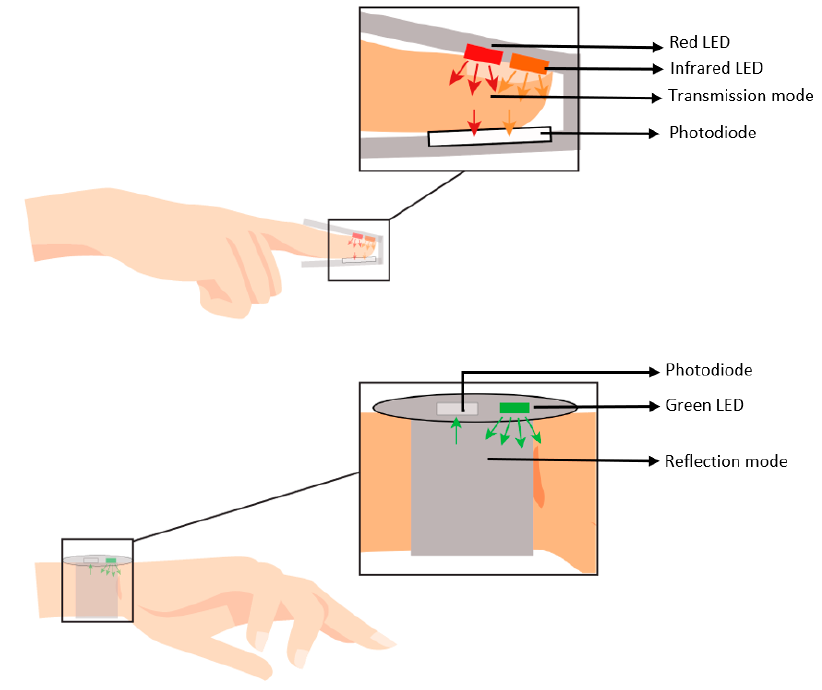
Figure 4. PPG transmissive mode vs. reflective mode . Figure 3. PPG transmissive mode vs. reflective